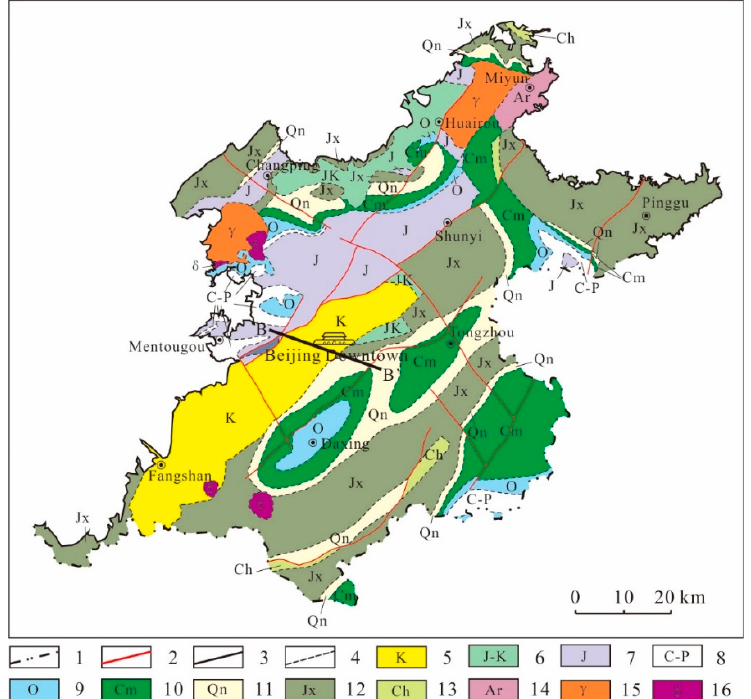
Figure 2. Geological sketch map of the Beijing plain area, showing strata and their distribution. 1—Administrative boundary of Beijing; 2—Faults; 3—Boundary between mountainous area and plain area in Beijing; 4—Stratigraphic boundary; 5—Cretaceous System; 6—Jurassic System and Cretaceous System; 7—Jurassic System; 8—Carboniferous System and Permian System; 9— Ordovician System; 10—Cambrian System; 11—Qingbaikou System; 12—Jixian System; 13—Changcheng System; 14—Archean Erathem; 15—Intrusive rock (granite); 16—Intrusive rock (diorite).